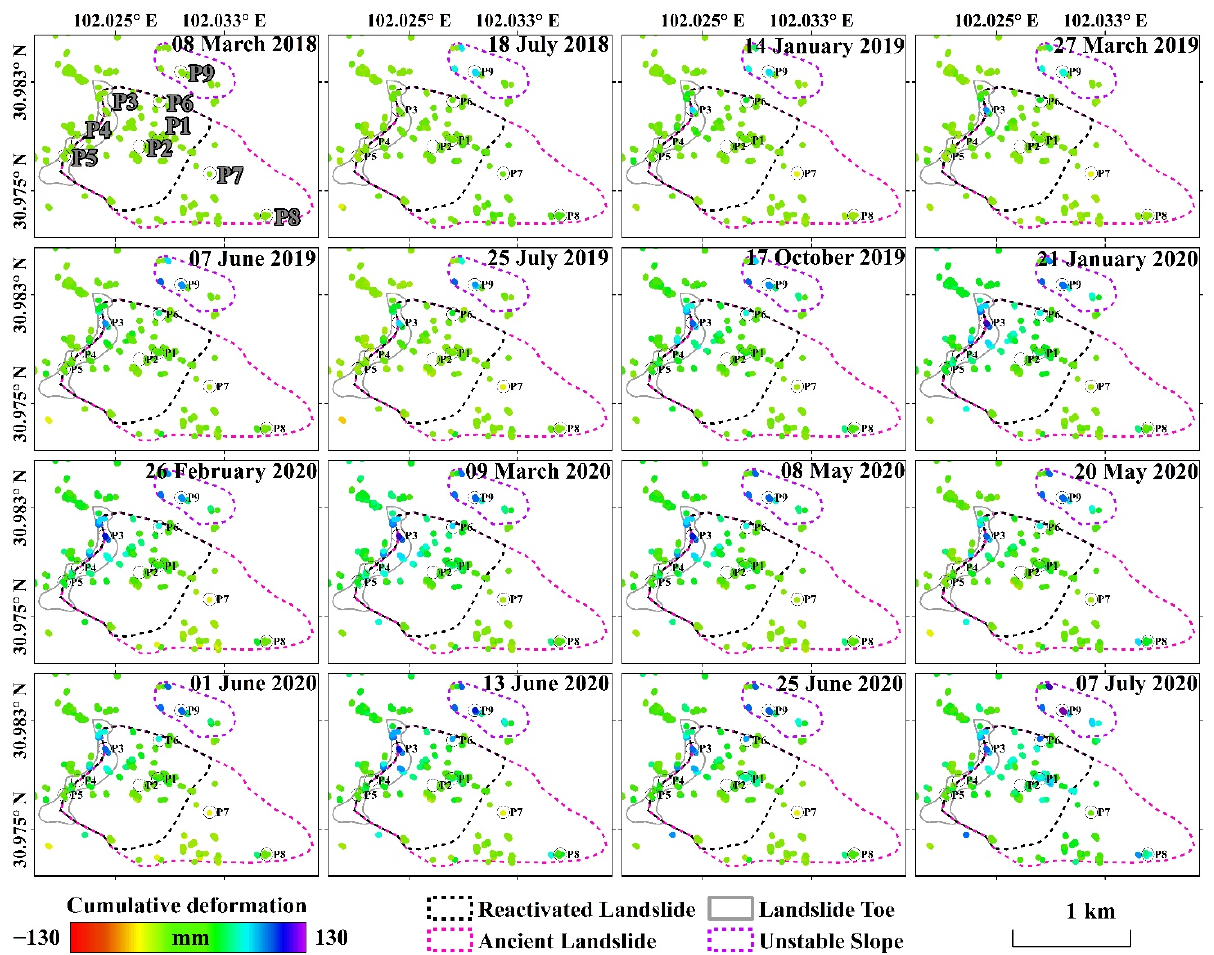
Figure 12. Ascending cumulative LOS deformation of the measurement points located at the Aniangzhai slope for the 16 selected acquisition dates of Sentinel-1 descending datasets, referring to the first SAR image acquired on 8 March 2018.